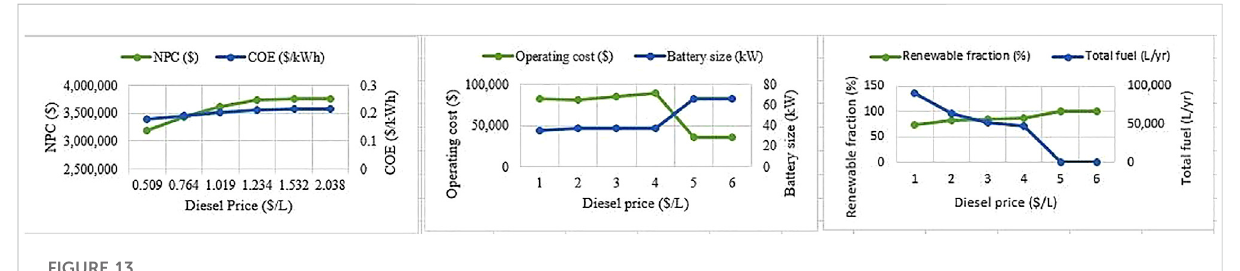
FIGURE 13 Effect of diesel price variation on selected dependent